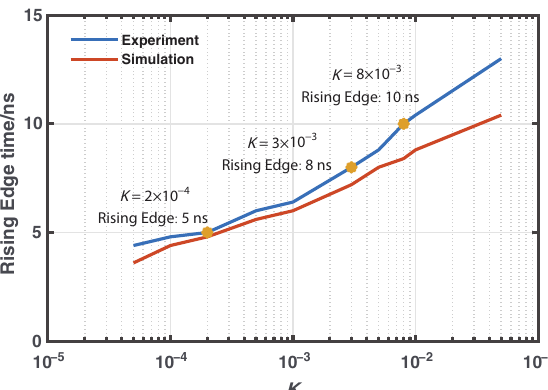
Figure 7. Evolution of the rising edges of the estimated Raman signals based on both experimental and simulated data over parameter K